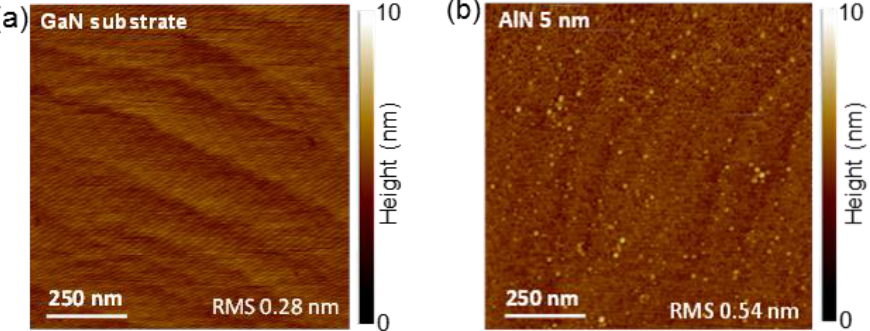
Figure 1. Morphological images of the virgin GaN substrate ( a ) and after PE-ALD of 5 nm thick AlN film ( b film ( b ).